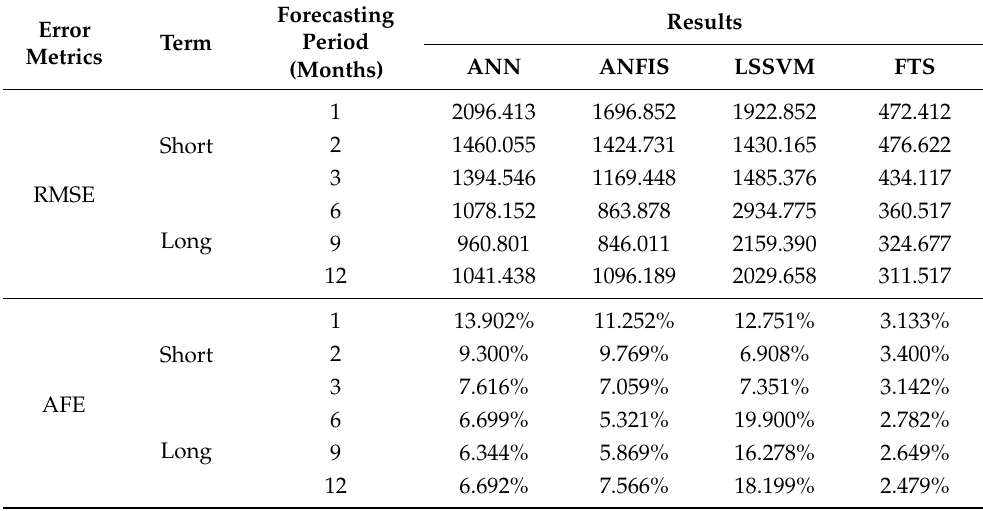
Table 5. Short-term and long-term forecasting results for